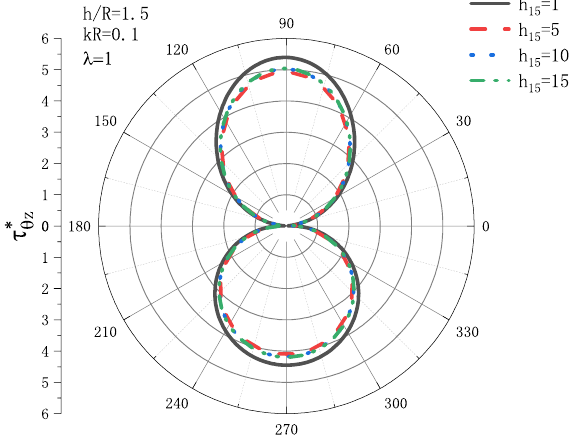
Figure 5. Variation of τ ∗ θ z vs. the ratio of h 15 when incident frequency kR = 0.1